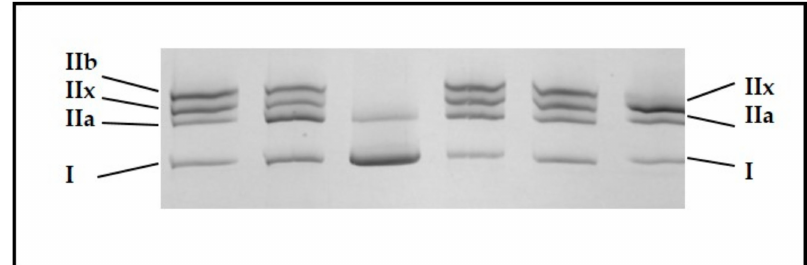
Figure 2. Illustration of the separation of the di ff erent myosin heavy chains isoforms depending on their molecular weight in di ff erent cattle skeletal muscles according to the protocol of Picard et al.